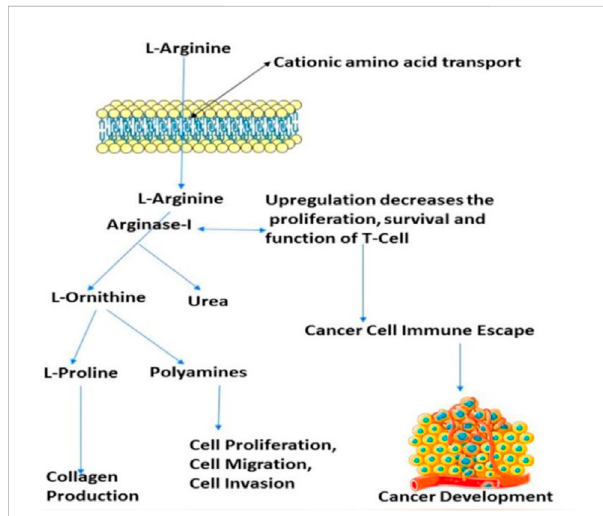
FIGURE 1 Presentation of the involvement of arginase-I in the cancer development, and immune